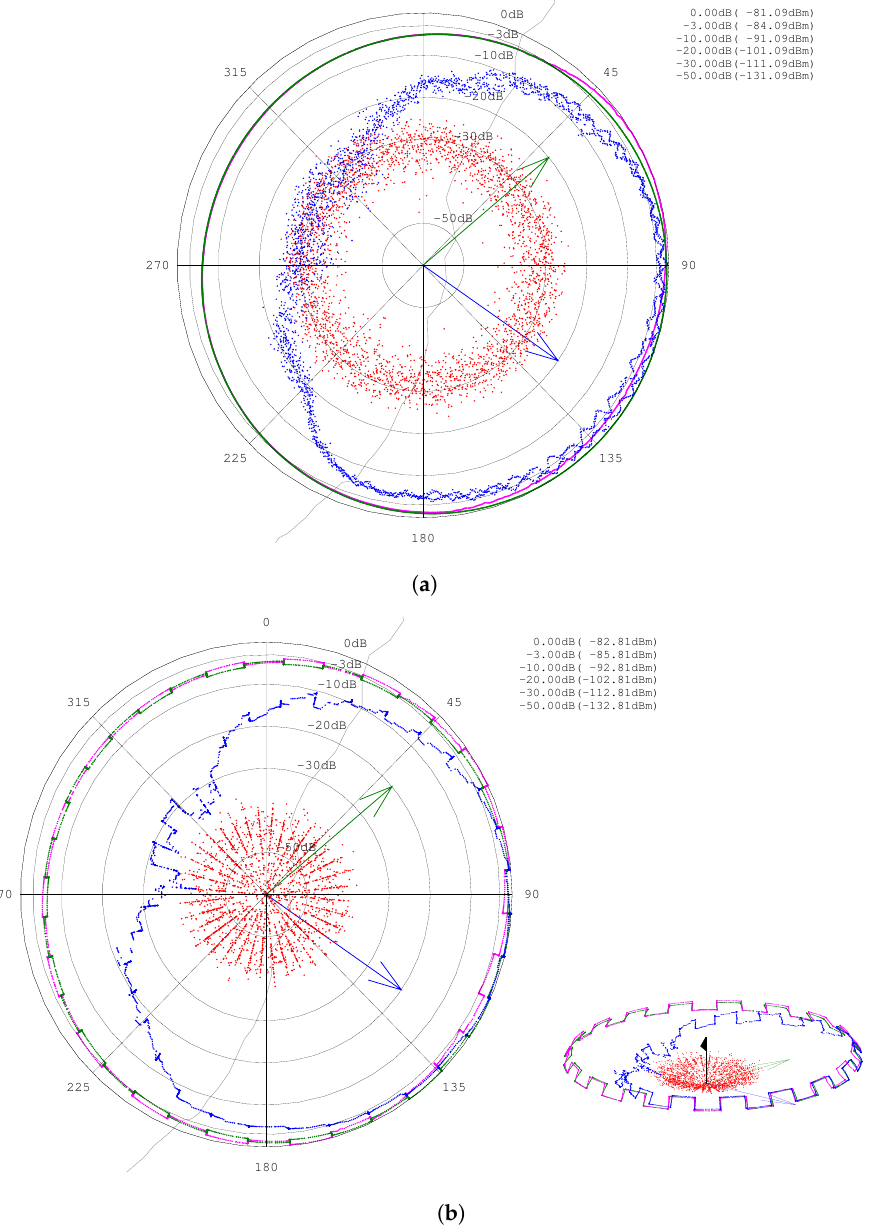
Figure 11. Results of the APM performed on the TWLA deployed at Red Head site on 22 October 2019 ( a ). Similar measurements performed on 29 January 2020 are given in ( b ). The small inset in ( b ) shows a perspective view of the measurements and simulation results facing north (black arrow) which helps highlight the multi altitude nature of this run. See (Figure 10) for colour